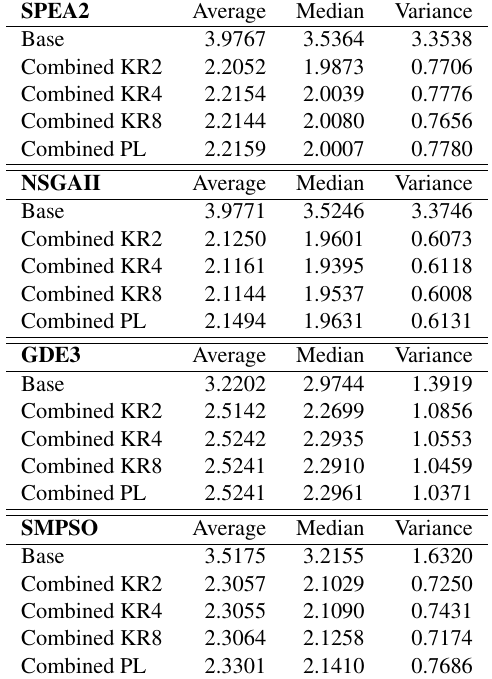
Table 2. ST - Stability metric.